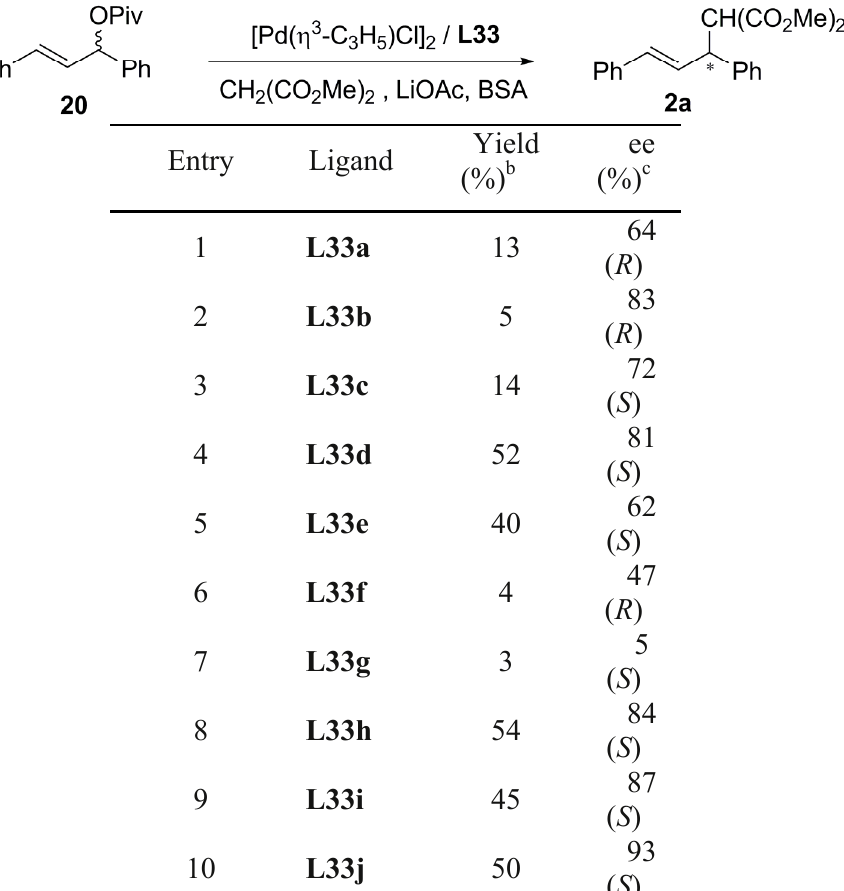
Table 3. Catalytic behaviour of ligands L33 in asymmetric allylic alkylation of 20